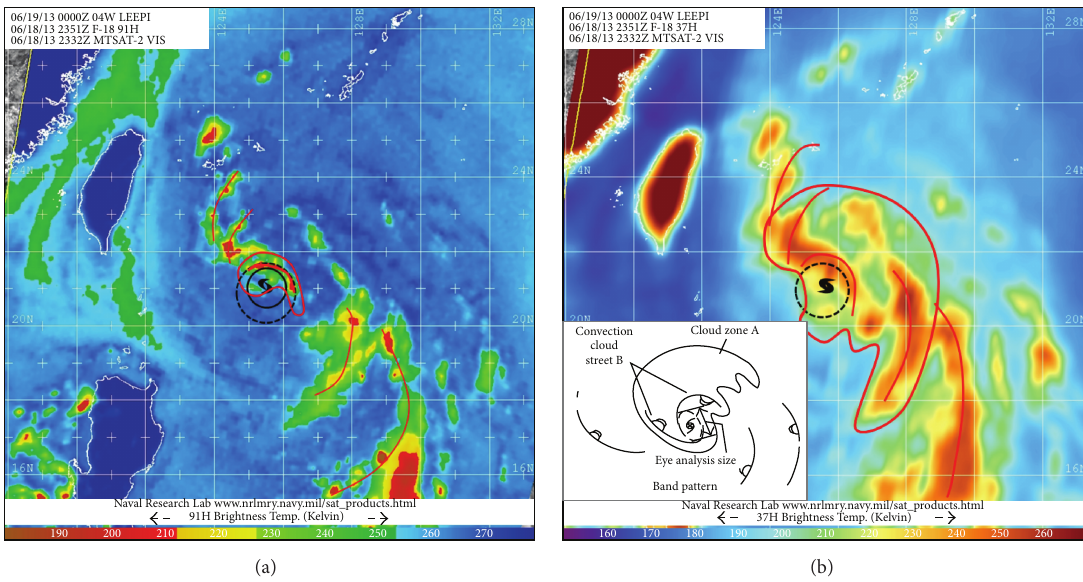
Figure 6: The same as Figure 5, but with respect to microwave imagery: (a) 91GHz and (b) 37 GHz. Solid circle means the optimal PI. The schematic diagram on the bottom left shows estimation of a TC center and eye analysis size (or a range similar to PI) of a band pattern cloud and was excerpted from the